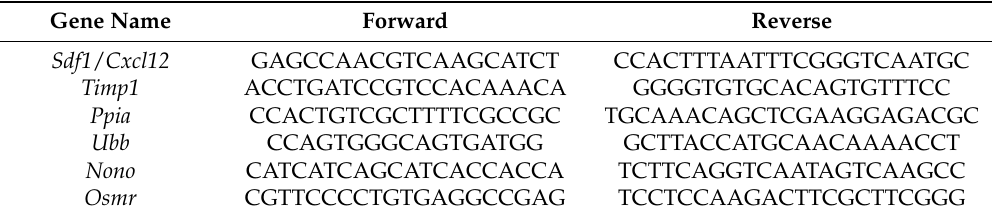
Table 1. Primers used for